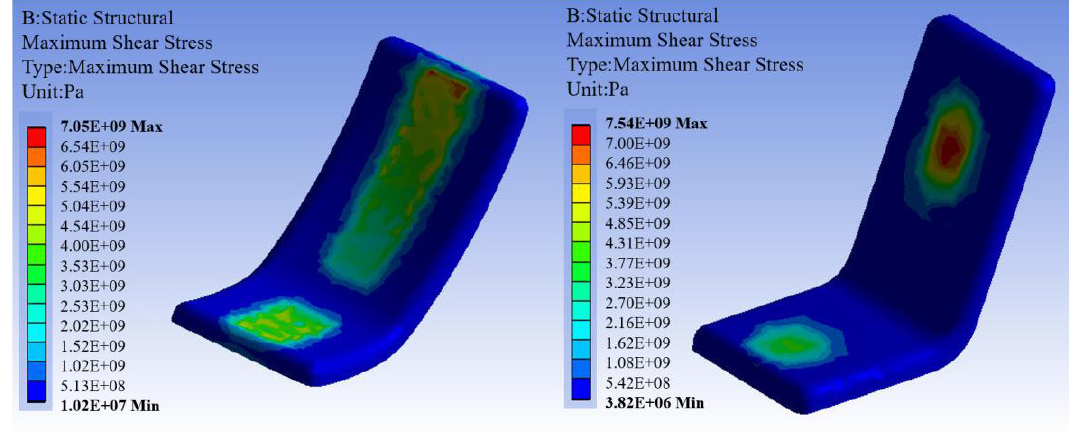
Figure 27. Stress analysis for comparison of the chair.